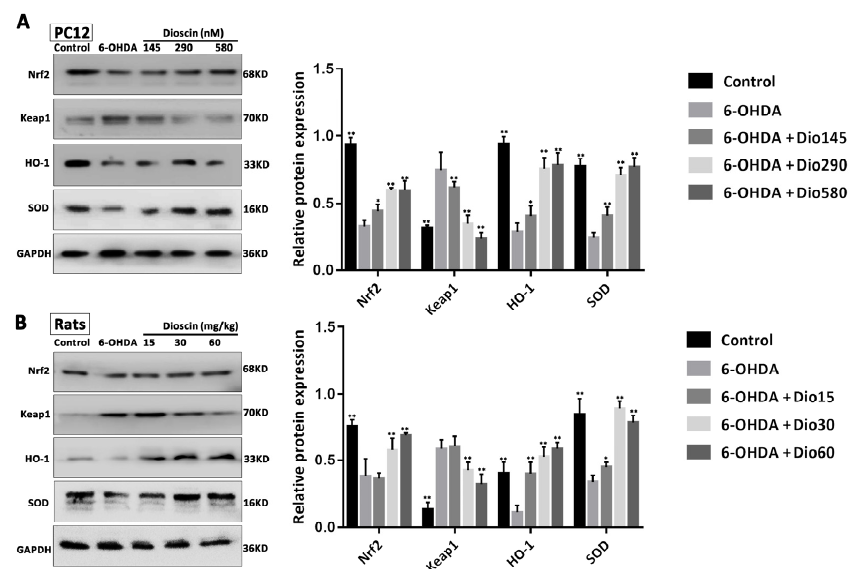
Figure 7. Effects of dioscin on Keap1/Nrf2 signal. ( A ) Effects of dioscin on the expression levels of Keap1, Nrf2, HO-1 and SOD by Western blotting assay in PC12 cells. ( B ) Effects of dioscinon the expression levels of Keap1, Nrf2, HO-1 and SOD by Western blotting assay in rats. Data are expressed as the mean ± SD ( n = 3). * p < 0.05 and ** p < 0.01 compared with the 6-OHDA